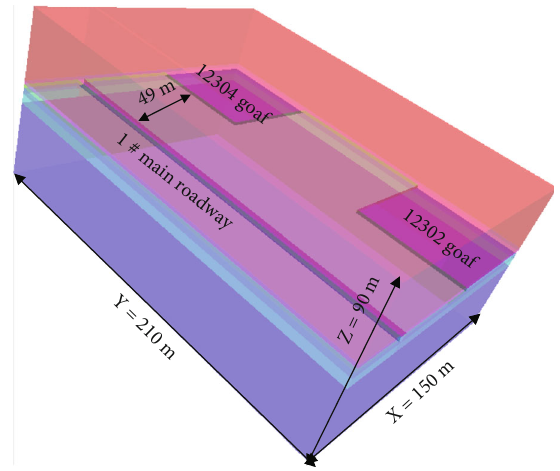
Figure 7: Numerical